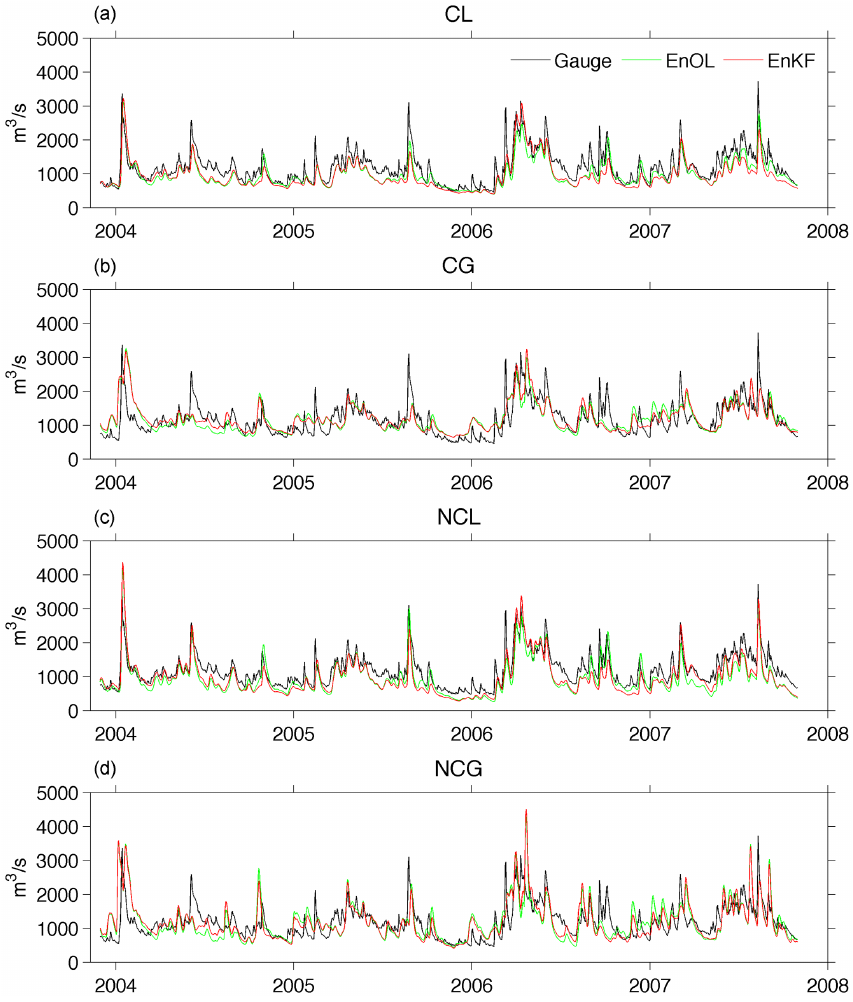
Figure 9. Estimated and observed streamflow at the Maxau gauge station in four different scenarios (CL: calibrated parameters with local forcing data; CG: calibrated parameters with global forcing data; NCL: non-calibrated parameters with local forcing data; NCG: non- calibrated parameters with global forcing